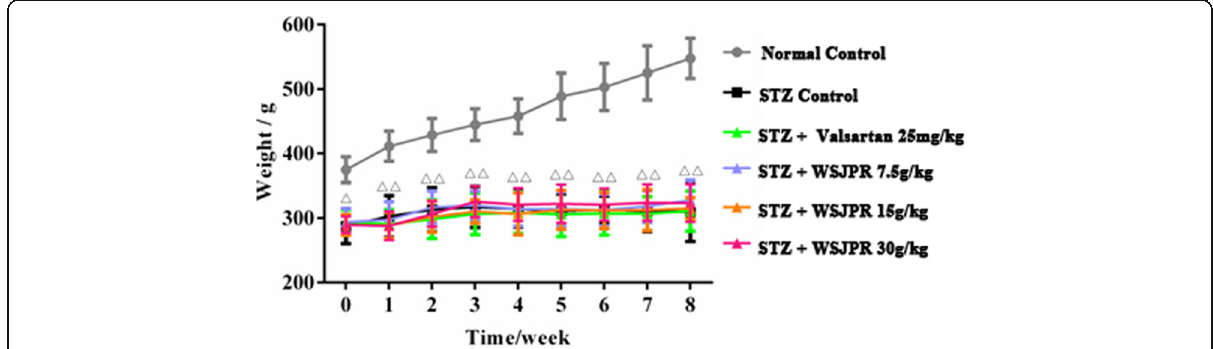
Fig. 1 Effect of WSJPR on body weight in rats at different times ( n = 8). △ P < 0.05, △△ P < 0.01 vs. normal control; mean ±